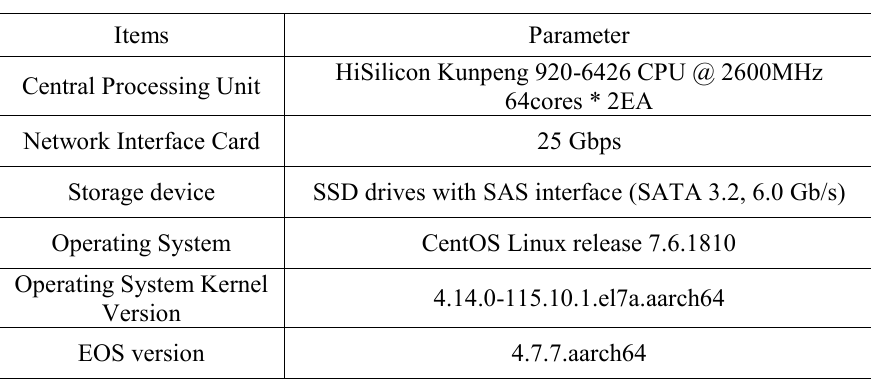
Table 1. Machines used for the